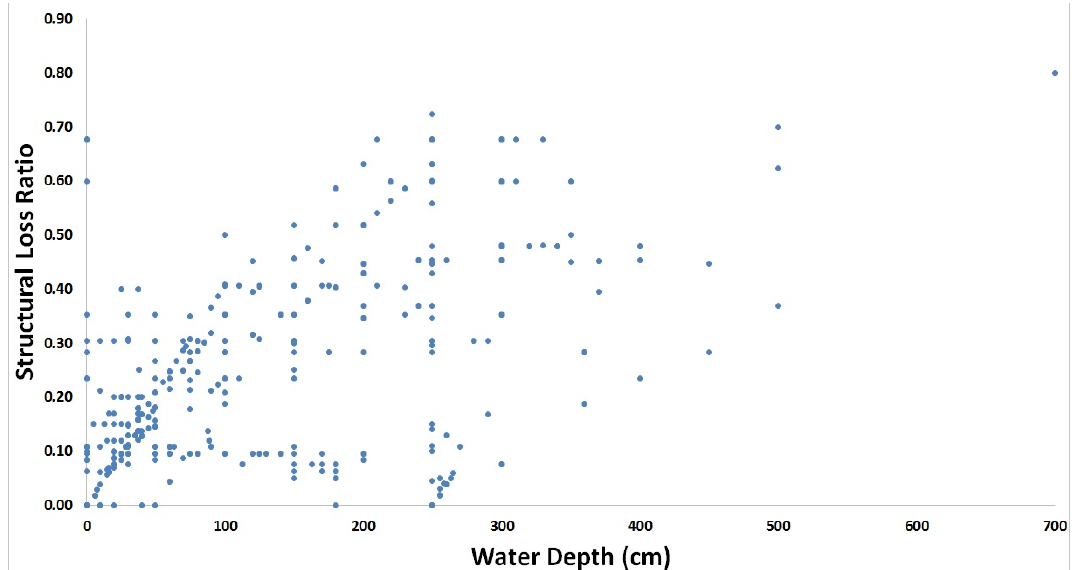
Table 2. Pearson correlation of the 13 final candidate predictors, see Table 1, and loss ratio. Significant correlations (5% significance level) are marked bold.